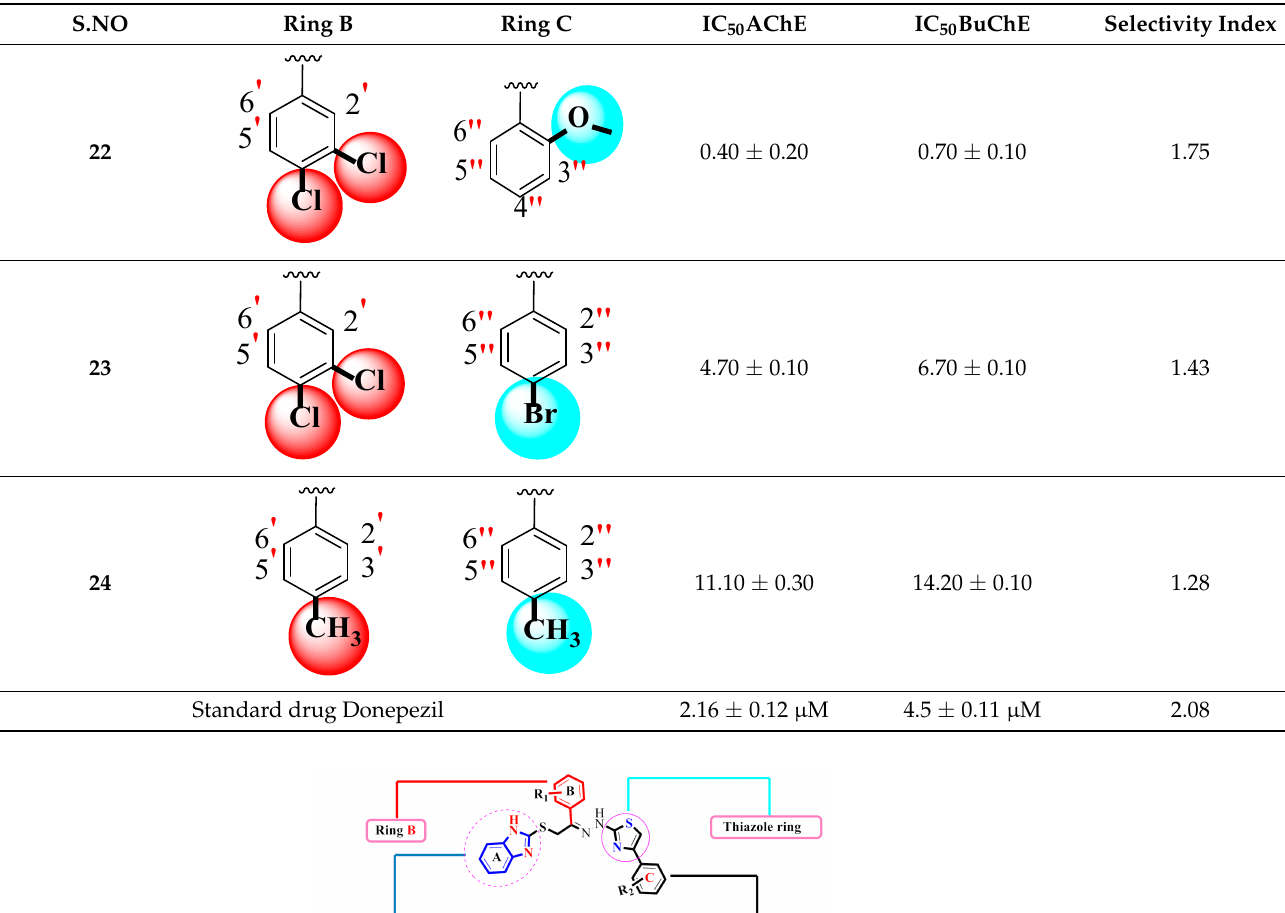
Figure 4. General structure of benzimidazole-bearing 1,3-thiazole scaffolds (1 – 24) . Structure–Activity Relationship of acetylcholinesterase and butyrylcholinesterase activities The derivative 21 (IC 50 = 0.10 ± 0.05 µ M and 0.20 ± 0.05 µ M), bearing di-Cl groups at meta - and para -positions of both phenyl rings B and C correspondingly, was emerged as most effective inhibitors of both targeted enzymes (AChE & BuChE). Additionally, the analogue 16 (IC 50 = 0.20 ± 0.050 µ M for AChE) and 0.50 ± 0.050 µ M for BuChE), which had a hydroxy group at the para -position of phenyl ring C and a nitro group at the ortho - position of phenyl ring B was found to be the 2nd most potent inhibitor of both AChE & BuChE enzymes. The different types, number (s), electron-donating or -withdrawing effect, positions of substituent(s) on the both phenyl rings B and C may account for the effective inhibitory potentials of analogues 16 and 21 (Figure 5).